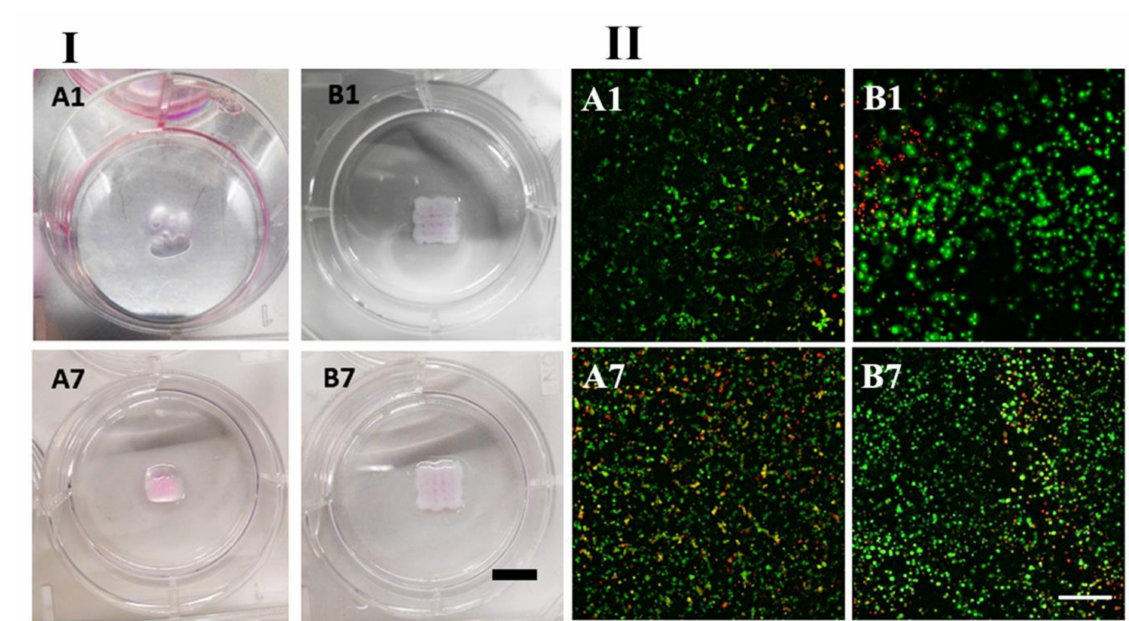
Figure 6. ( I ) Images of 3D bioprinted hydrogels, and ( II ) cell viability in bioprinted constructs. ( A ) PVA-Nb and ( B ) PVA- Nb/SDCM50 at day 1 and day 7. Scaffolds bioprinted in the geometry of a cube. Porous-like structures can be seen in the PVA-Nb/SDCM50 scaffold (scale bar 10: mm). Green stain represents live cells and red stain represents dead cells (scale bar 100 µ